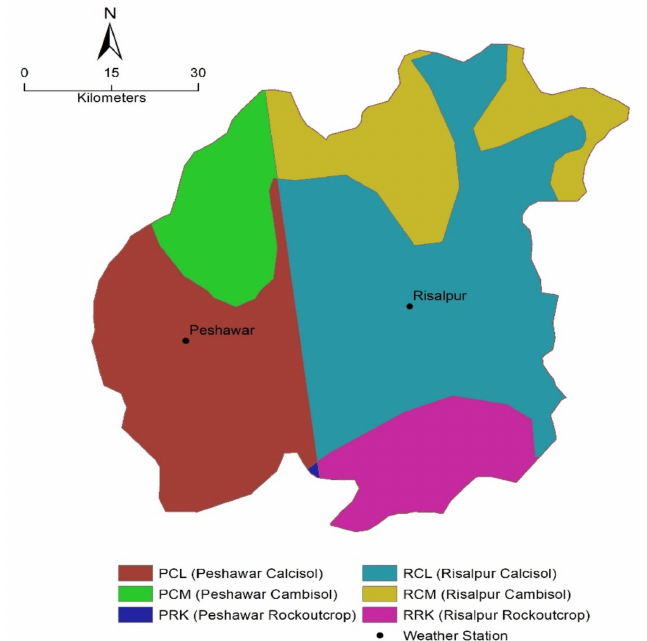
Figure 2. Sub-regions of Peshawar Basin with overlayed soil and climate